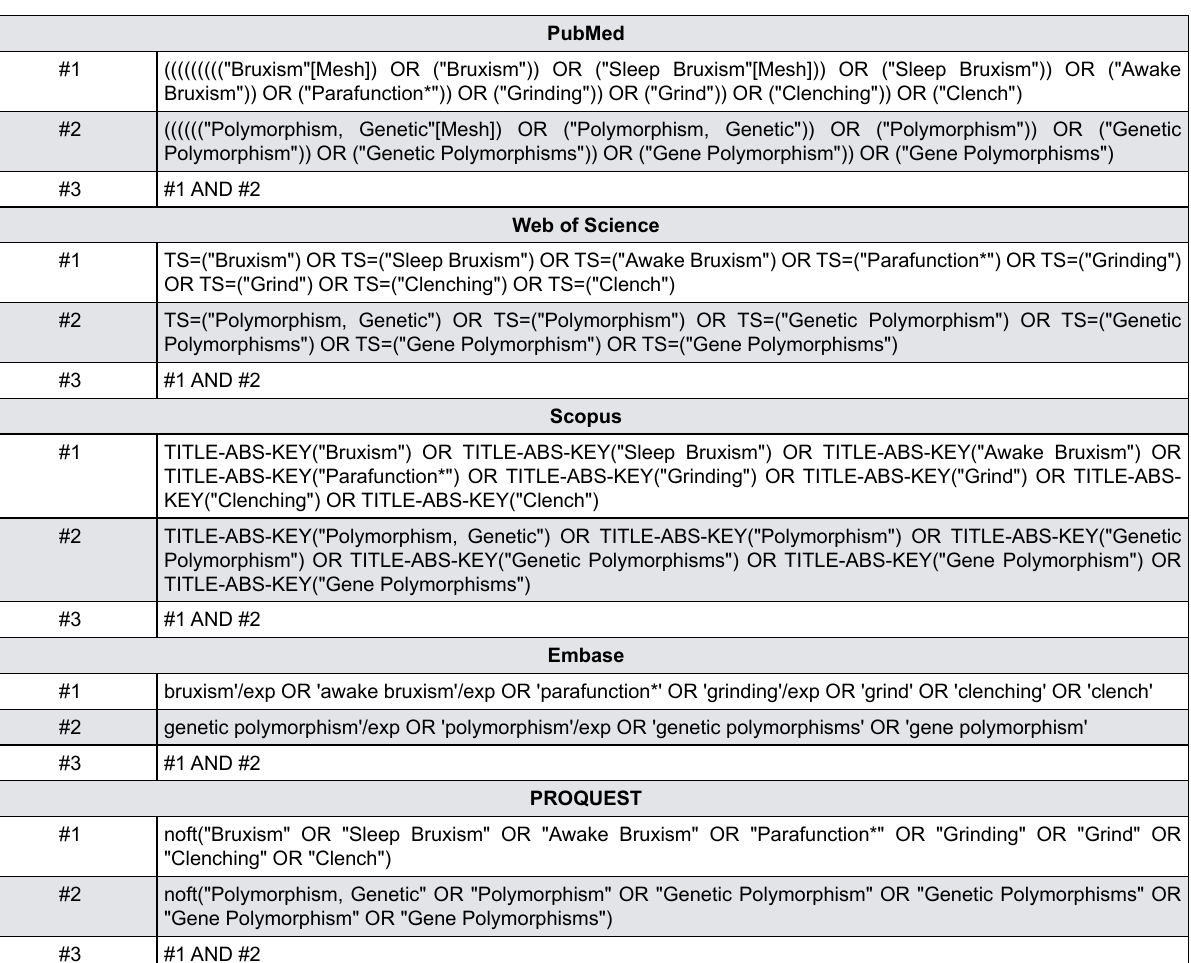
Figure 1- Search strategy in each electronic